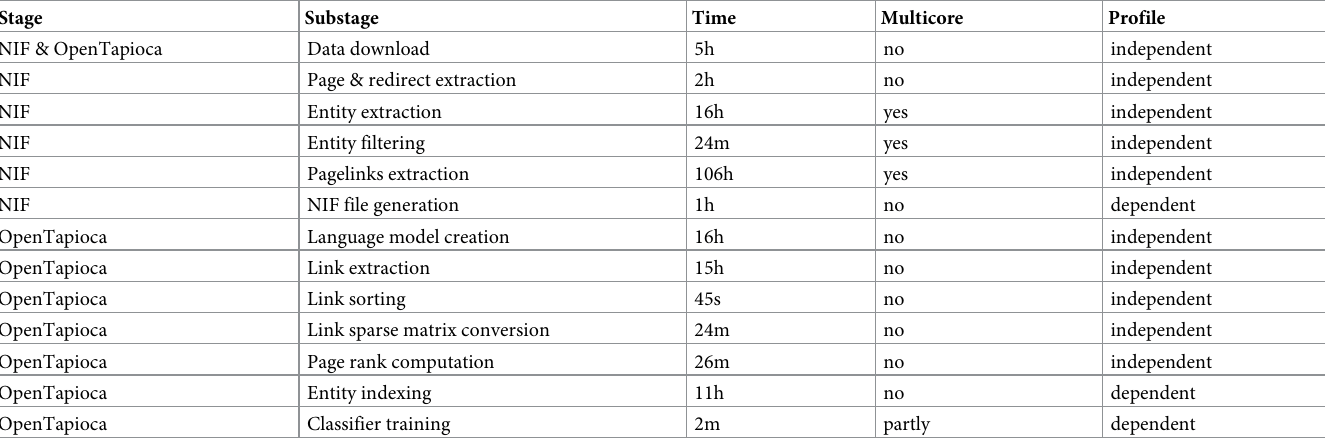
Table 1. Build Processing